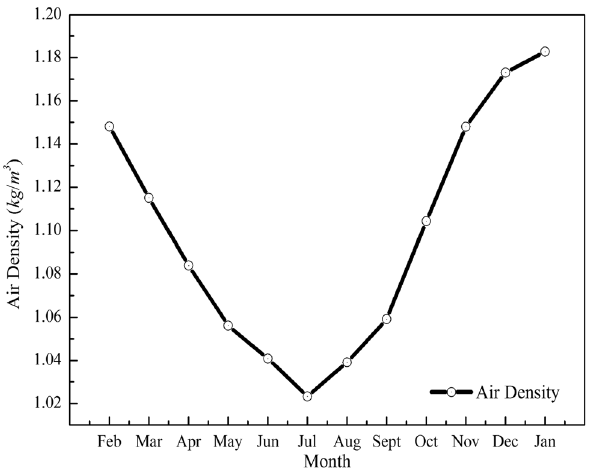
Figure 6. Average change of air